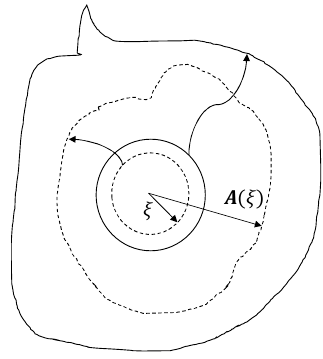
Figure 2. A vector state A mapping a sphere into a complex surface.